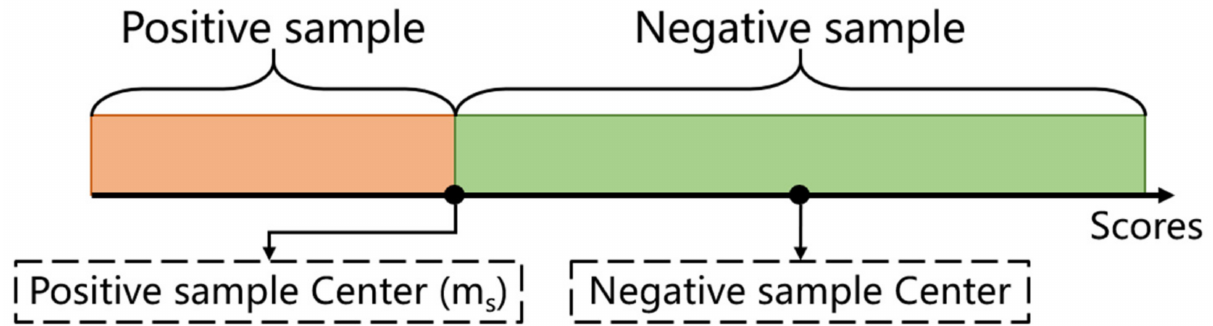
Figure 5. The criteria for dividing positive and negative